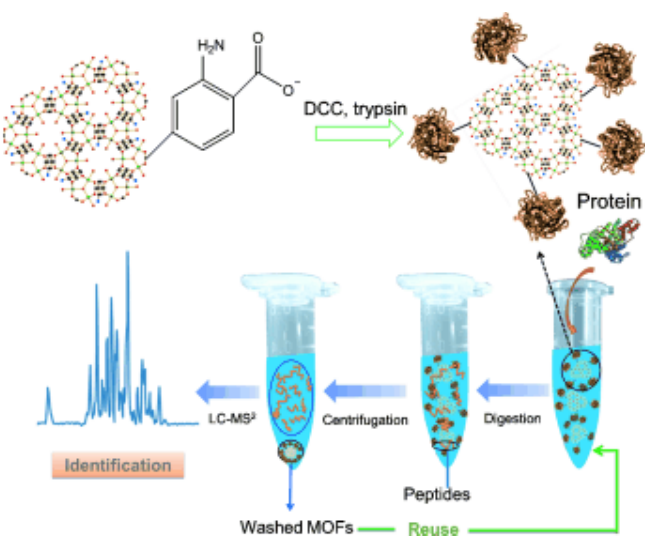
Figure 4. Schematic of trypsin immobilization on MIL-88B-NH 2 (Cr), protein digestion through trypsin-MOF, and identification by LC-MS 2 . Reproduced from [39] with permission from John Wiley and Sons, copyright 2012.